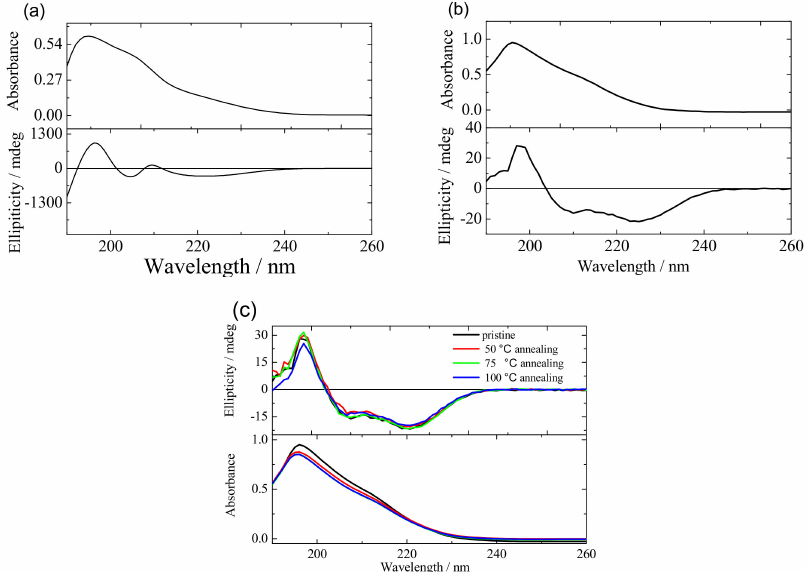
Figure 3. UV absorption and circular dichroism (CD) spectra of ( a ) as-deposited PMLG, ( b ) as-deposited PBLG film and ( c ) annealed PBLG